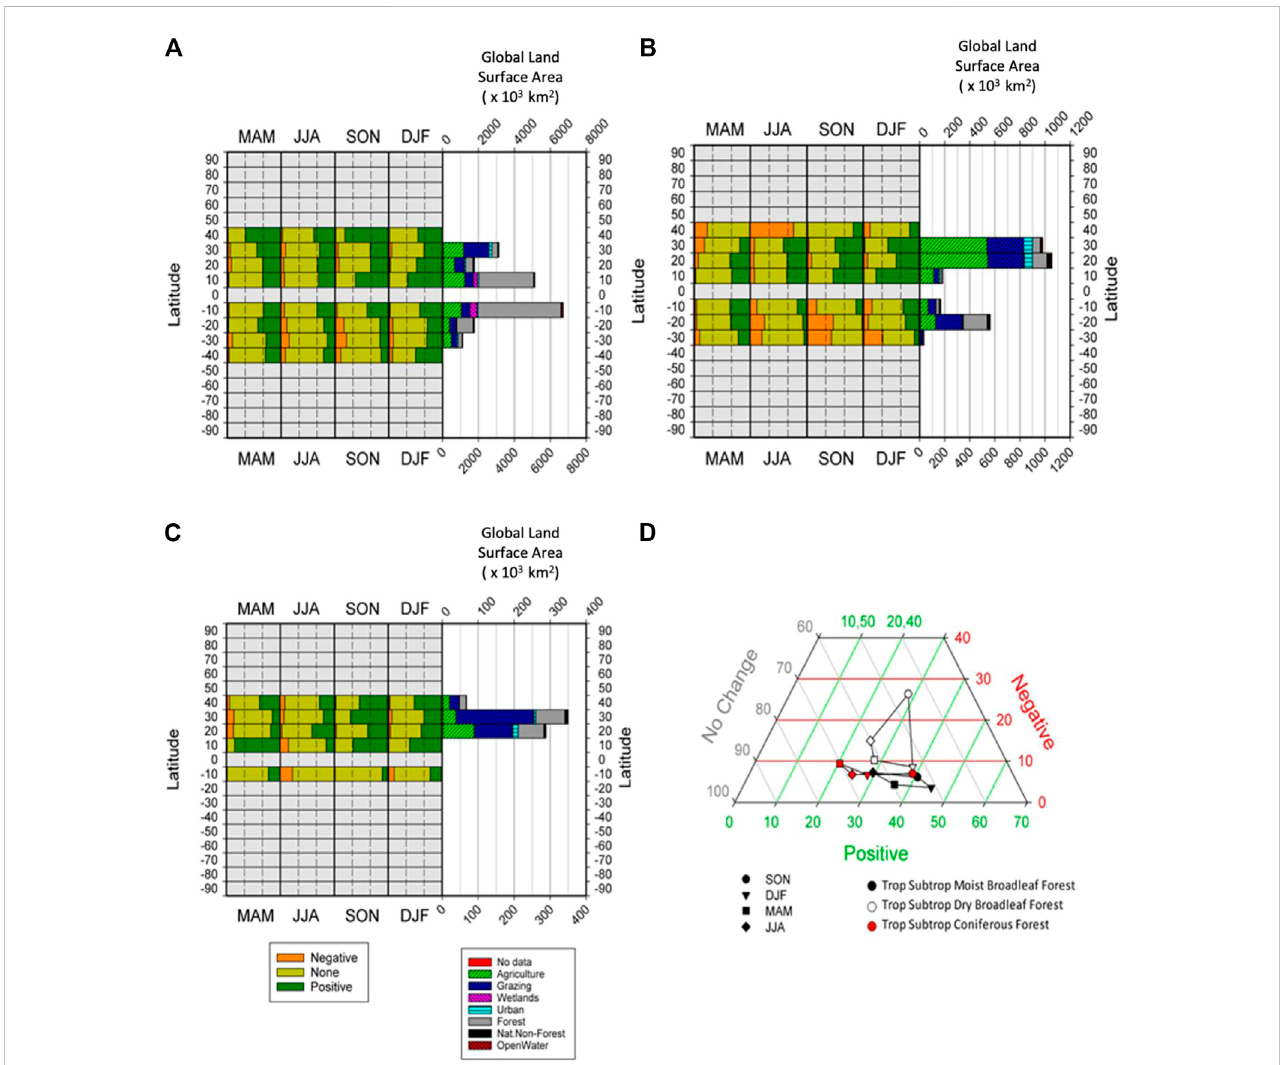
FIGURE 4 Composition of signi fi cant persistence values (Negative, None, Positive) in each biome, broken down by latitudinal band, with land use diversity of each bankalso shown, for (A) Tropical Subtropical Moist BroadleafForest, (B) TropicalSubtropicalDry Broadleaf Forest, (C) Tropical SubtropicalConiferousForest, and (D) Ternary plot of the seasonal changes in percentages of global areas returning signi fi cant percentages of positive and negative persistence, and those reporting to signi fi cant persistence, for three tropical forest